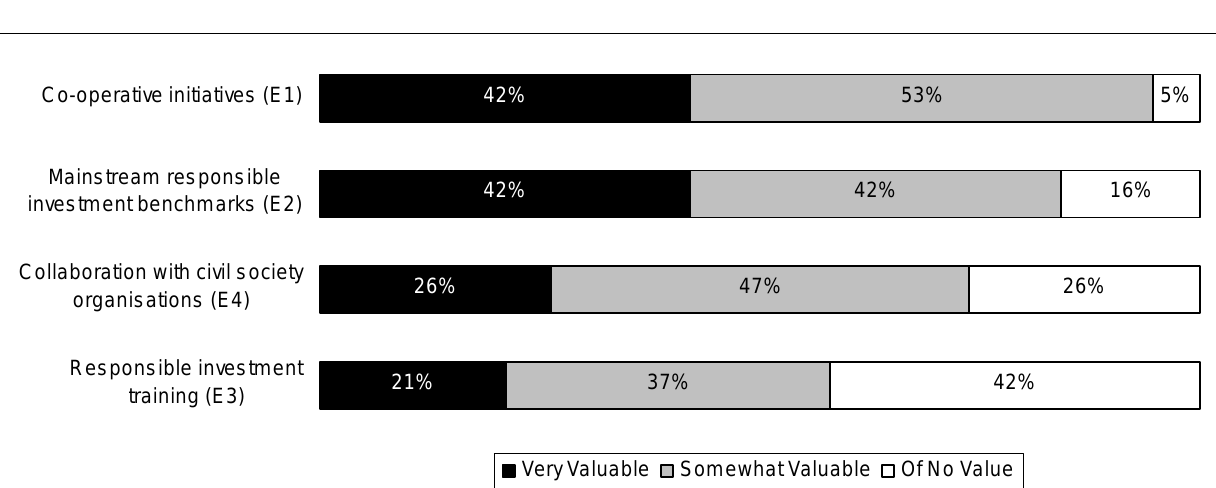
Figure 7: Pension funds – RI enablers